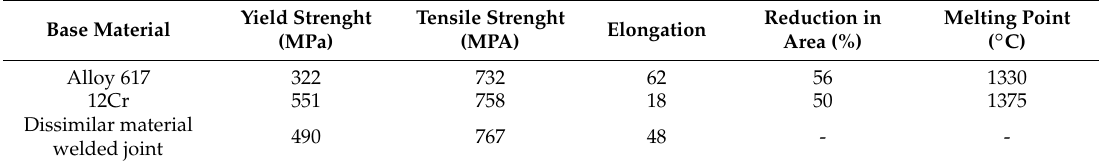
Table 1. Mechanical properties of alloy 617, 12Cr steel, and dissimilar material weld.